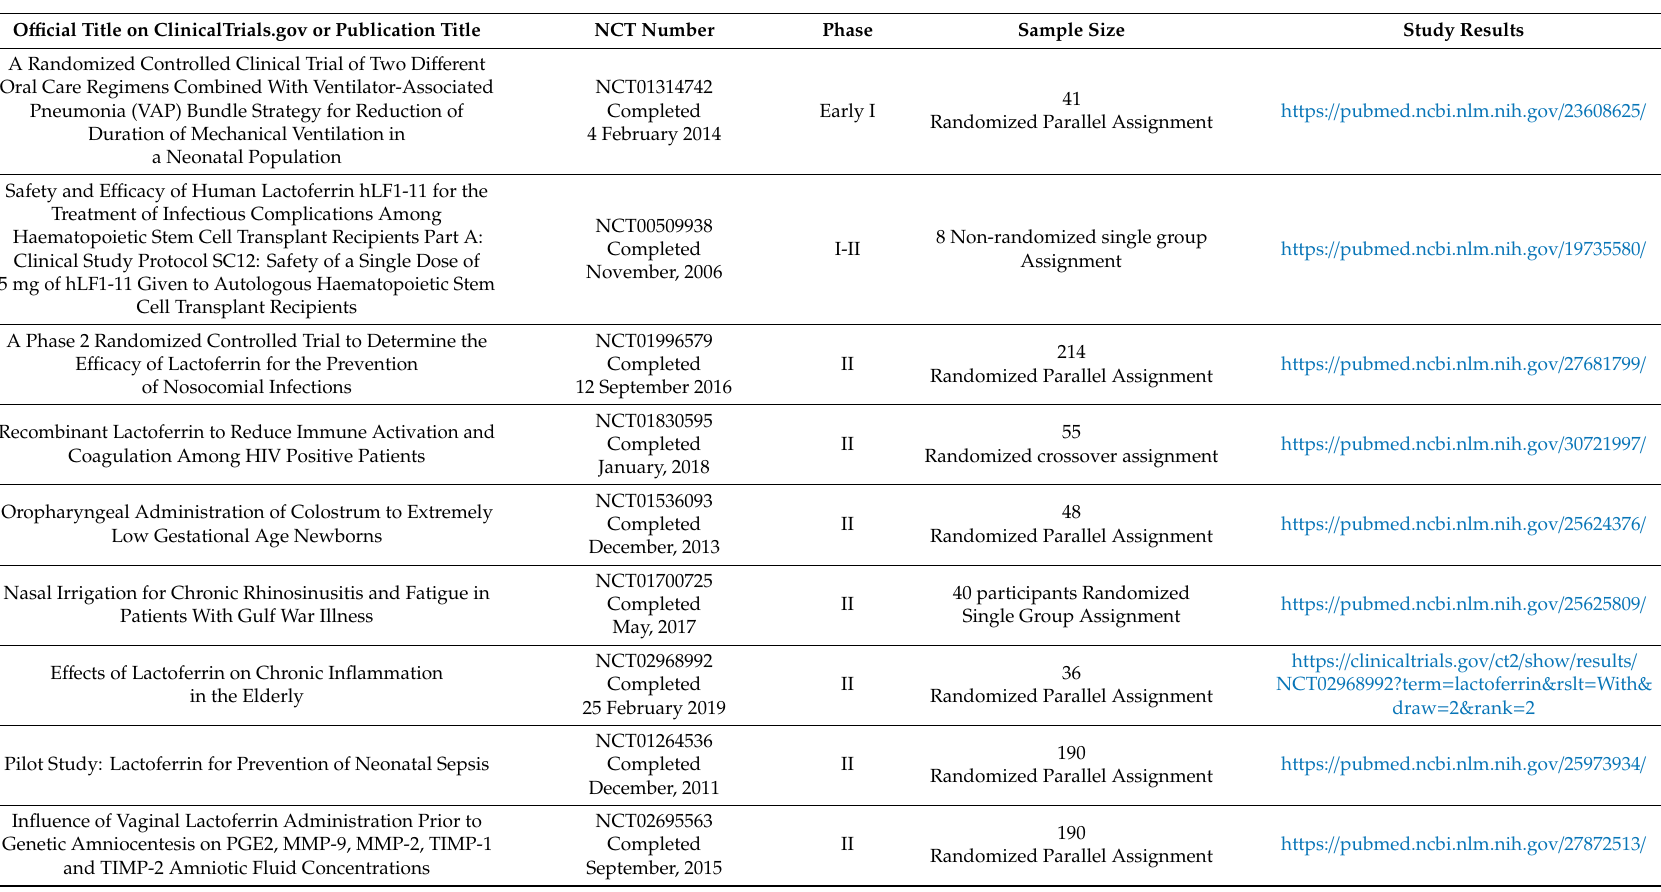
Table 1. Trials reported to strategy research. All trials have been checked on https: // pubmed.ncbi.nlm.nih.gov / and https: // clinicaltrials.gov / (accessed on 2 July